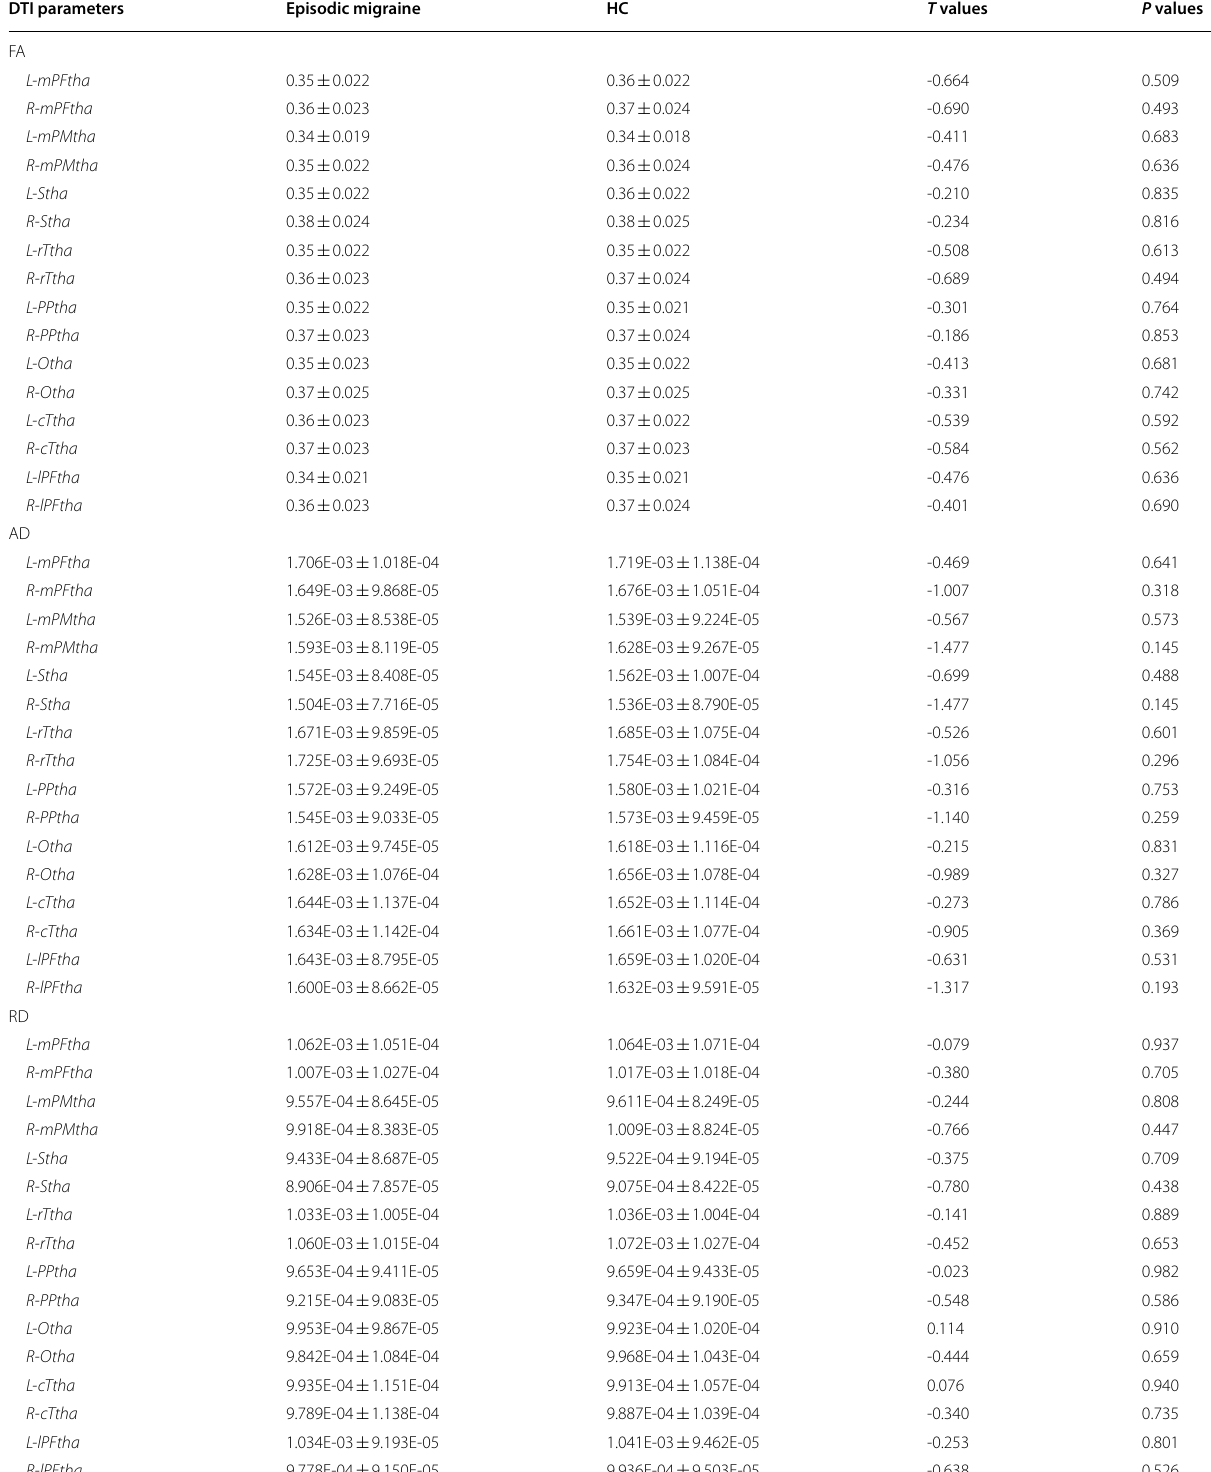
Table 4 DTI parameter (FA, AD, RD, MD) changes in the thalamic subregions in patients with episodic migraine compared with HCs DTI parameters Episodic migraine T